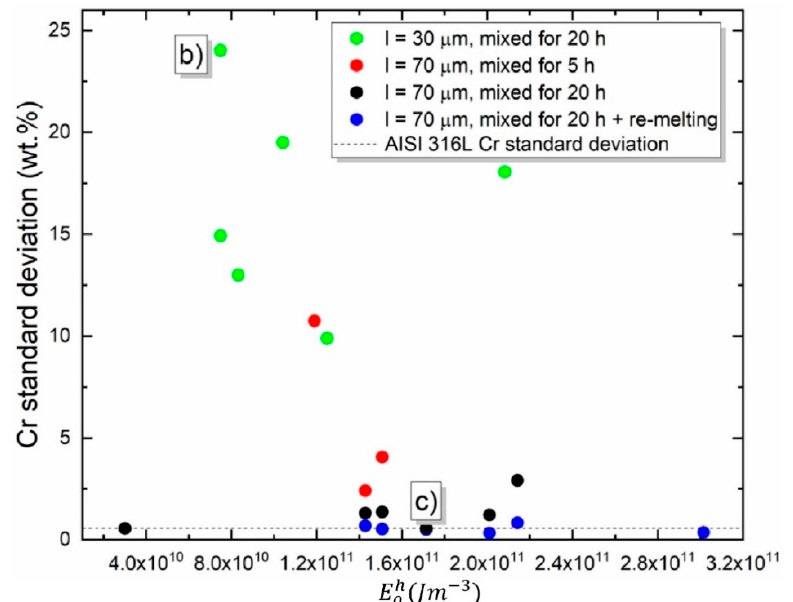
Figure A1. Schematic representation of the roller mixer used for mixing of elemental powder.